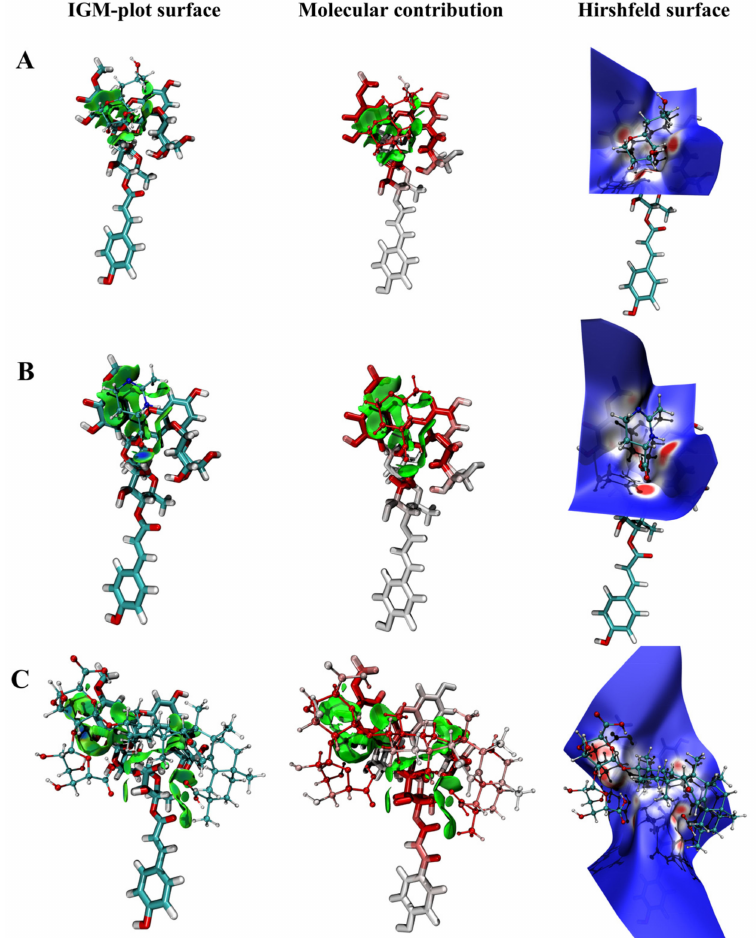
Figure 6. Non − covalent interaction for the anthocyanin (A 4 (cid:48) species) compound − binary complex by IGMH analysis. ( A ) p3cr5g − PX; ( B ) p3cr5g − ECT; ( C ) p3cr5g −